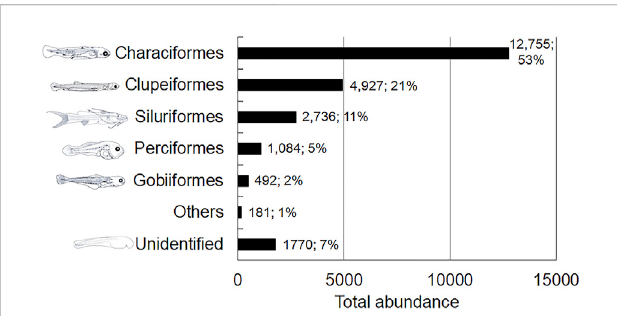
FIGURE 2 Total abundance and proportion of taxonomic orders of fi sh larvae captured in the Tapajós River, Amazon Basin, Brazil. Others = larvae of the Beloniformes, Gymnotiformes, Carangiformes, Synbranchiformes and Tetraodontiformes orders which together represented 1% of the larval captures during the